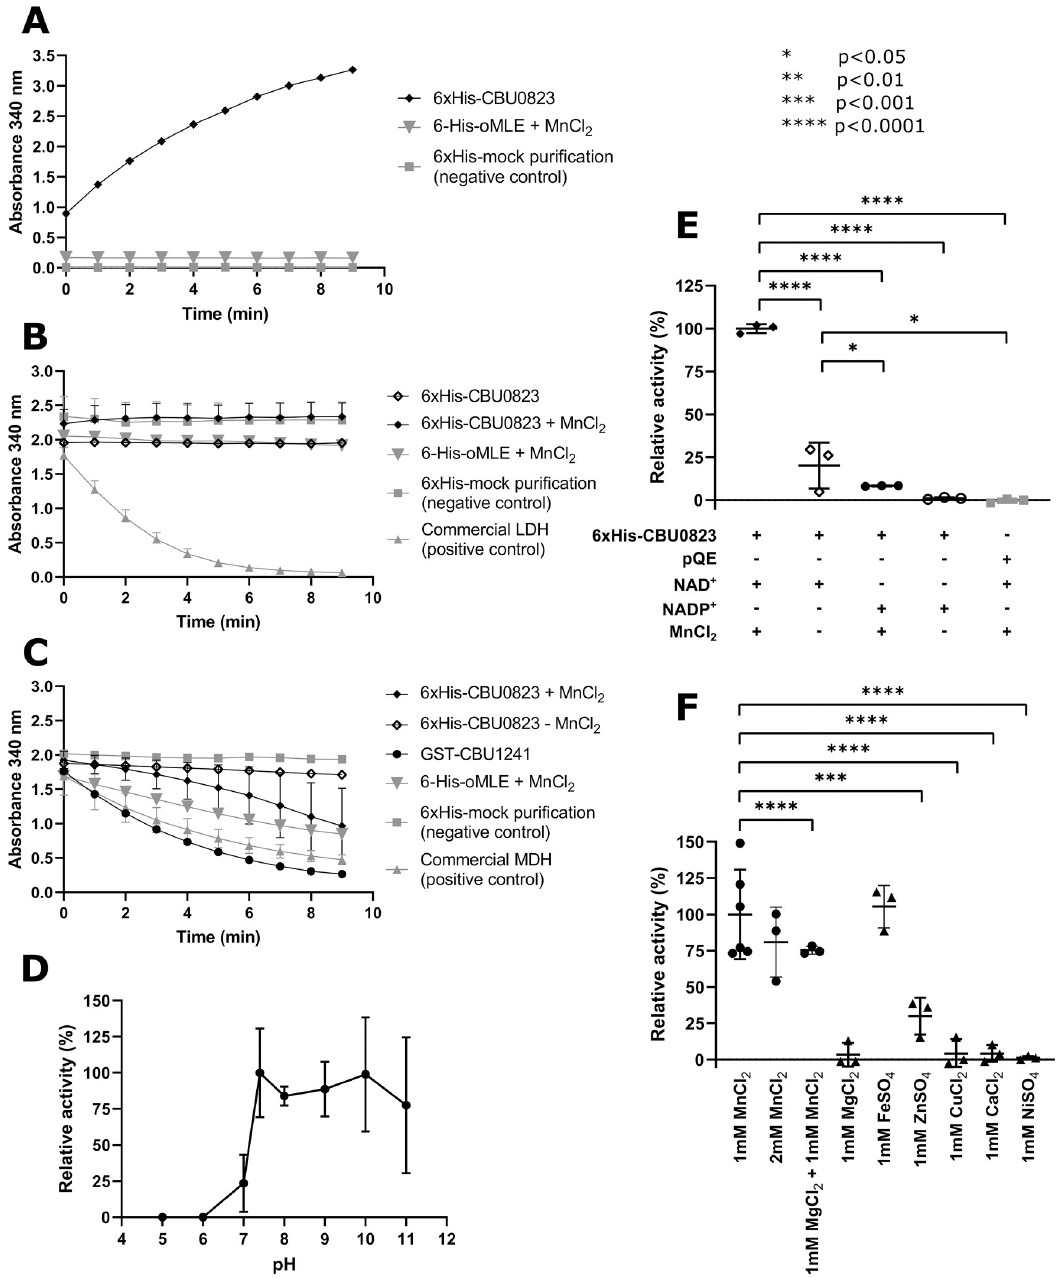
Fig 5. In vitro 6xHis-CBU0823 activity assays for ME (A), LDH (B) and MDH (C) function, including the influence of varied pH (D), and substituted cofactors (E and F). (A) ME activity was observed for 20 μ g 6xHis-CBU0823 in the ME standard assay containing 3 mM malate, 5 mM NAD + , 1 mM MnCl 2 . 28.8 μ g 6xHis-oMLE and 6xHis-mock purification negative control had no activity. (B) LDH activity was not detected for 20 μ g 6xHis-CBU0823 in the LDH standard assay containing 2 mM pyruvate and 0.5 mM NADH, with or without the addition of MnCl 2 . 28.8 μ g 6xHis-oMLE and 6xHis-mock purification also failed to show activity, while 0.1 units commercial LDH enzyme had measurable performance in standard conditions. (C) MDH activity was measured for 20 μ g 6xHis-CBU0823 in the MDH standard assay containing 2 mM OAA, 0.5 mM NADH, with improved action on addition of 1 mM MnCl 2 . 0.013 units commercial pig heart mitochondrial MDH and 1 μ g GST-CBU1241 had efficient activity in the assay and 6xHis-mock purification had no detectable activity. (D) Enzyme activity relative to pH 7.4 over a range of pHs, measured using ME standard assay containing 2 μ g 6xHis-CBU0823. Activity was measured using increase or decrease of light absorbance at 340 nm, correlating to NADH oxidation and NAD + reduction respectively during enzyme activity. (E) Removal of MnCl 2 and/or substitution with NADP + cofactor from the standard ME assay reduced 6xHis-CBU0823 activity. Conditions with significantly less activity are